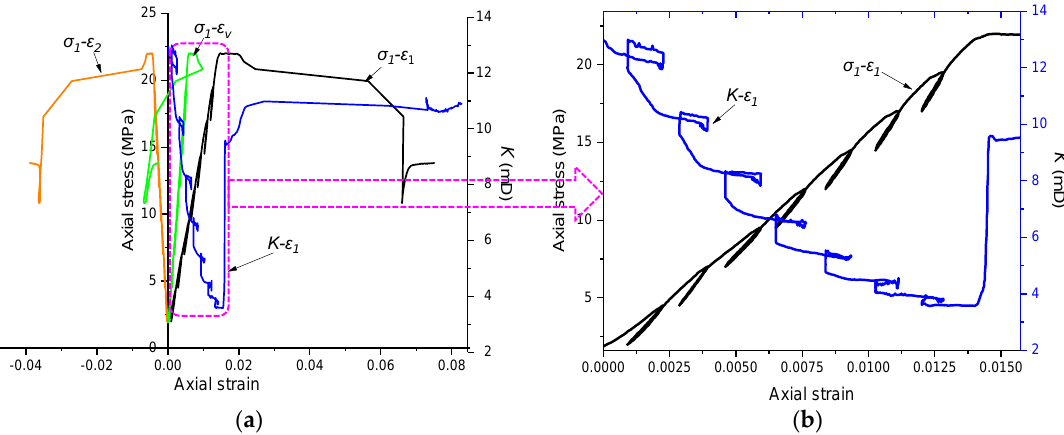
Figure 7. The relationships among the stress, strain, and permeability of raw coal under stress path 1. ( a ) Stress–strain and permeability–strain curves. ( b ) Partial enlargement of the axial stress–strain curve and the permeability–axial strain curve.